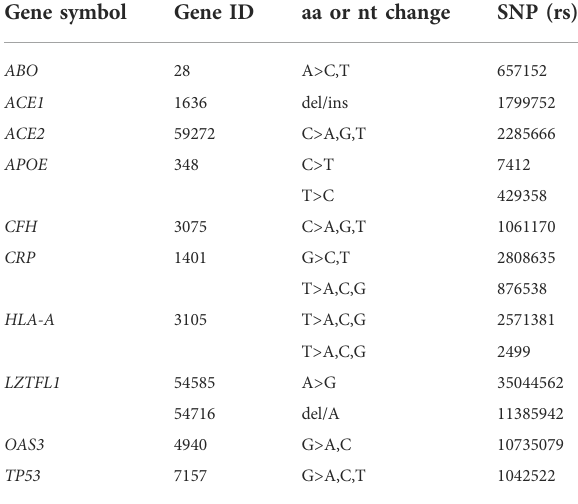
TABLE 2 Panel of gene and variants